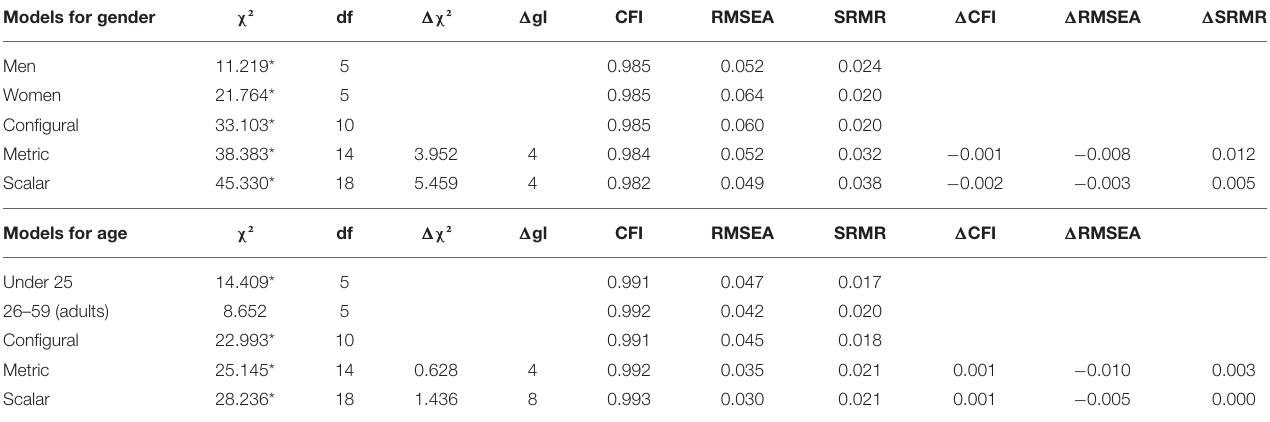
TABLE 3 | Measurement invariance models of the SWLS by gender (reference group: men) and by age (reference group: under 25). Models for